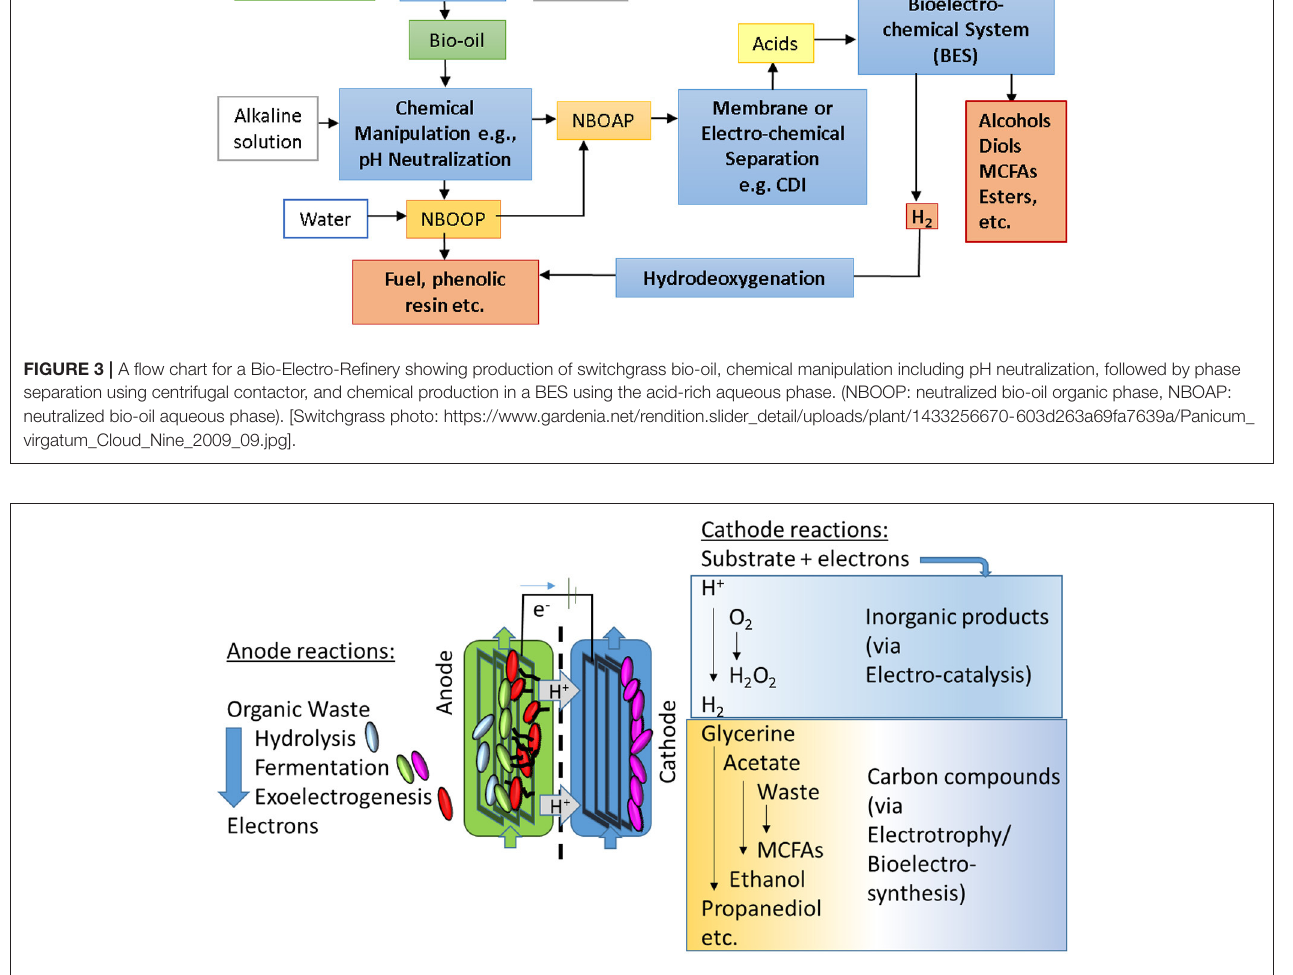
FIGURE 4 | Waste to electrons to products via an integrated bioelectrochemical